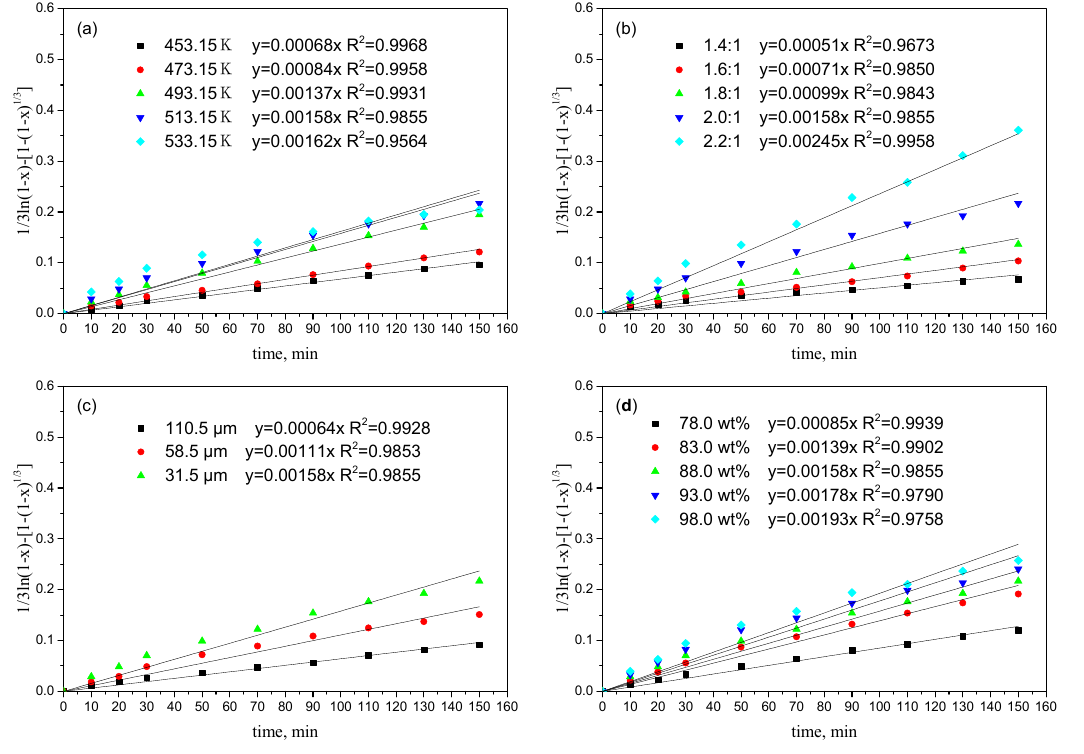
Figure 10. Plot of 1 ln ( 1 − X ) − [ 1 − ( 1 − X ) (cid:2869) (cid:2871)⁄ ] versus time with the variation in different parameters: ( a ) temperature; ( b ) acid / solid weight ratio; ( c ) particle size; ( d ) initial sulfuric acid concentration.